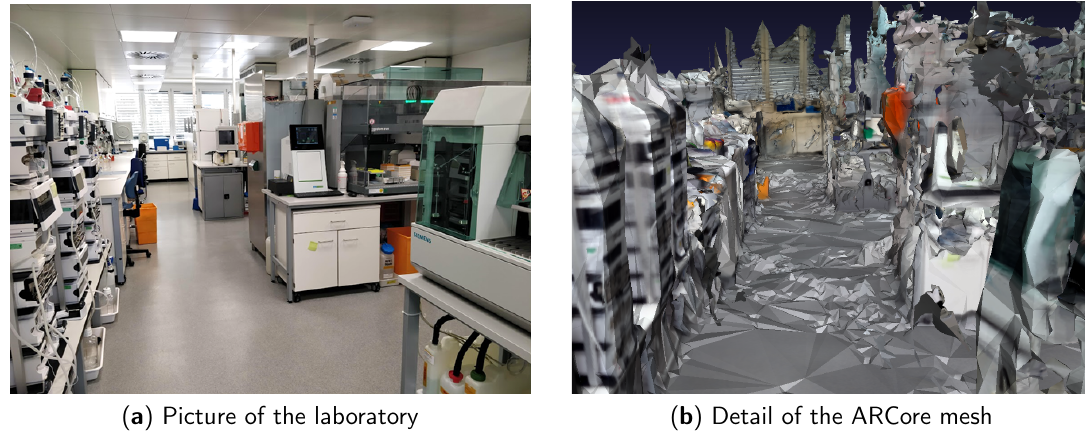
Figure 6. The laboratory in real life and as scanned.